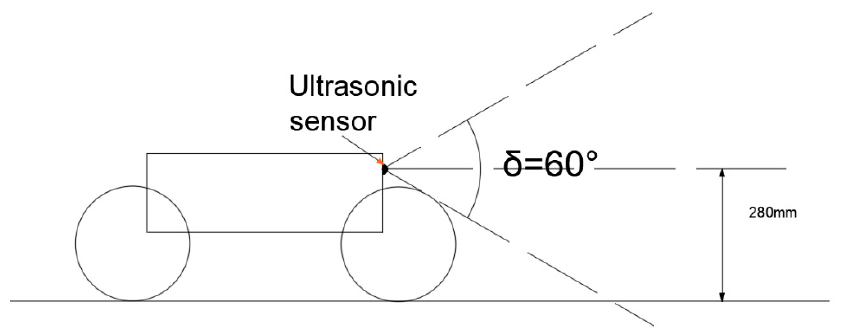
Figure 15. Schematic diagram of ultrasonic sensor sensing.